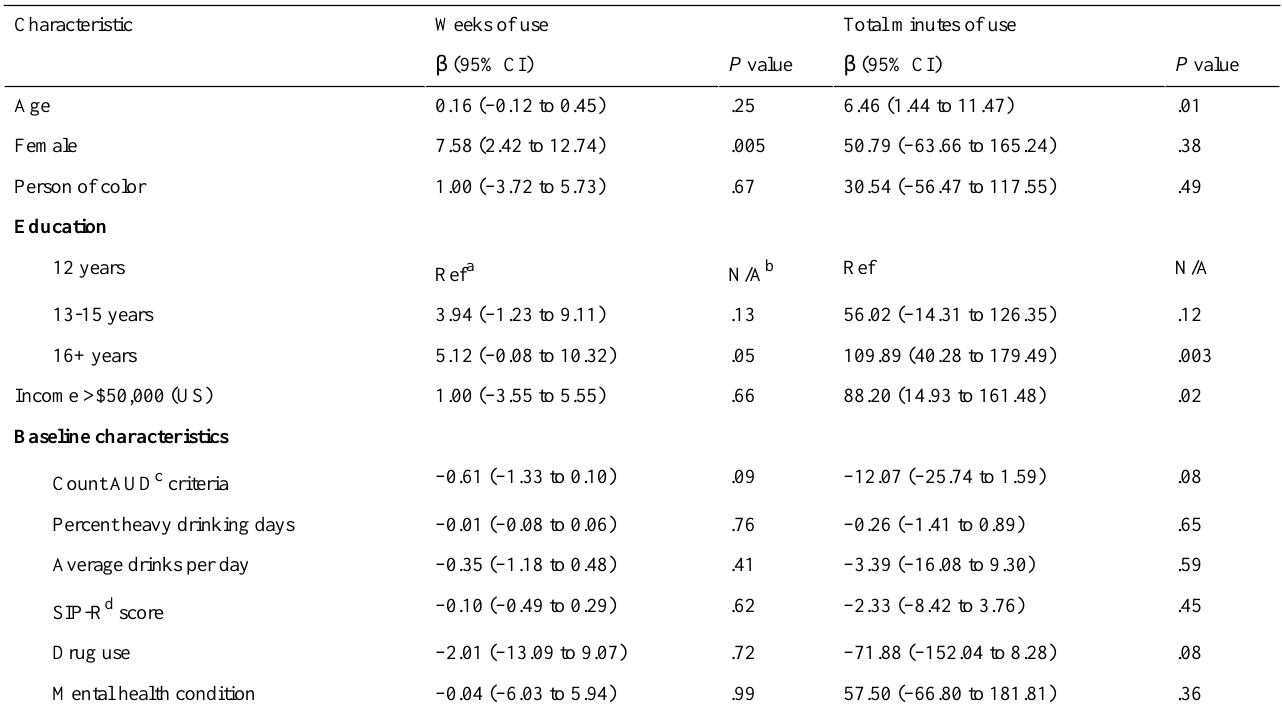
Table 3. Associations between participant characteristics and Step Away engagement.